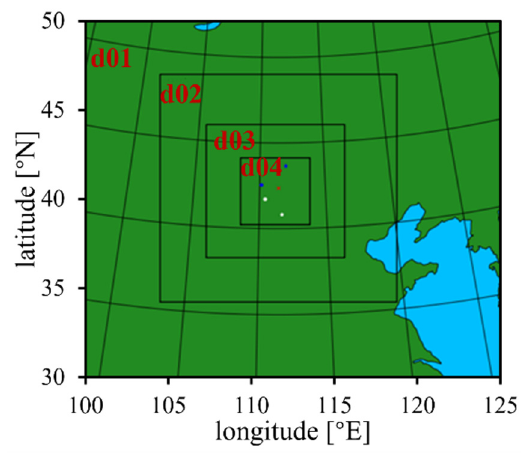
Figure 1. Geographical fourfold-nested domain covered by the WRF model.